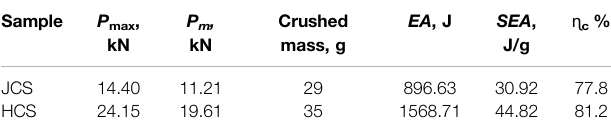
TABLE 2 | The mean crashworthiness parameter values of the hybrid and nonhybrid specimens.